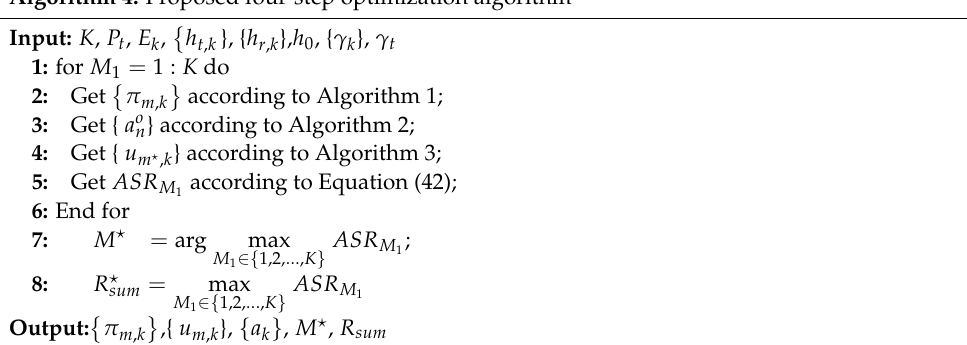
Algorithm 4. Proposed four-step optimization